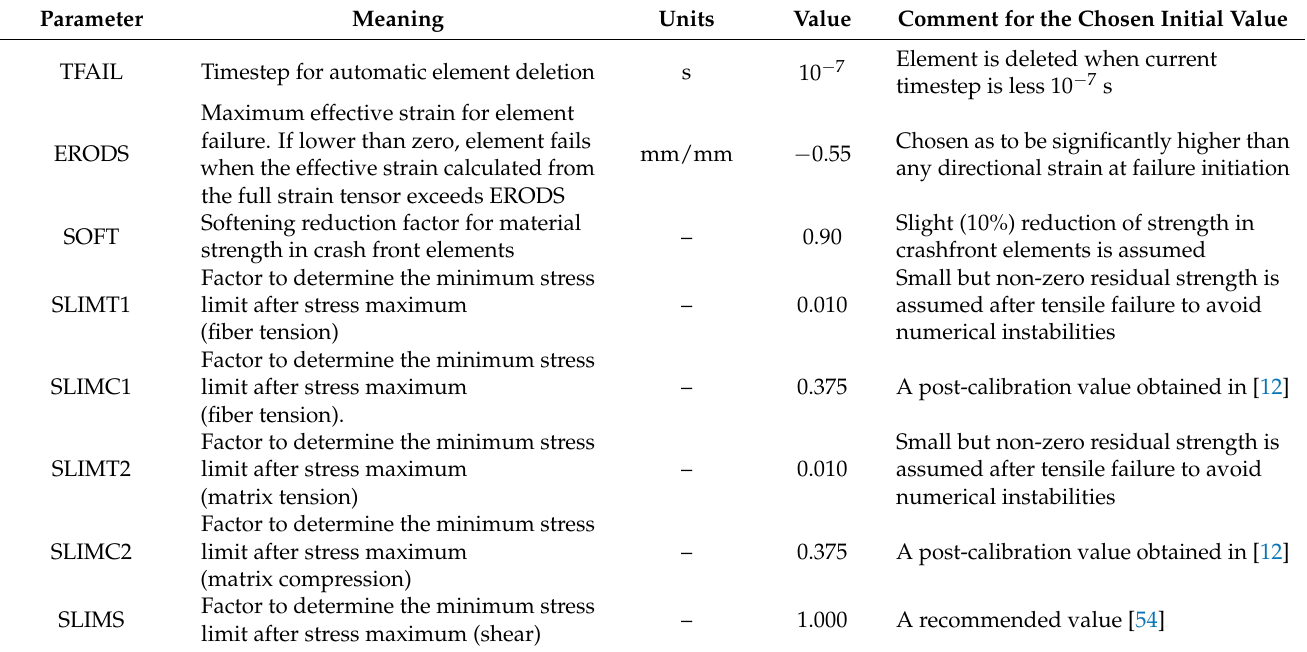
Table 4. The non-physical parameters for MAT